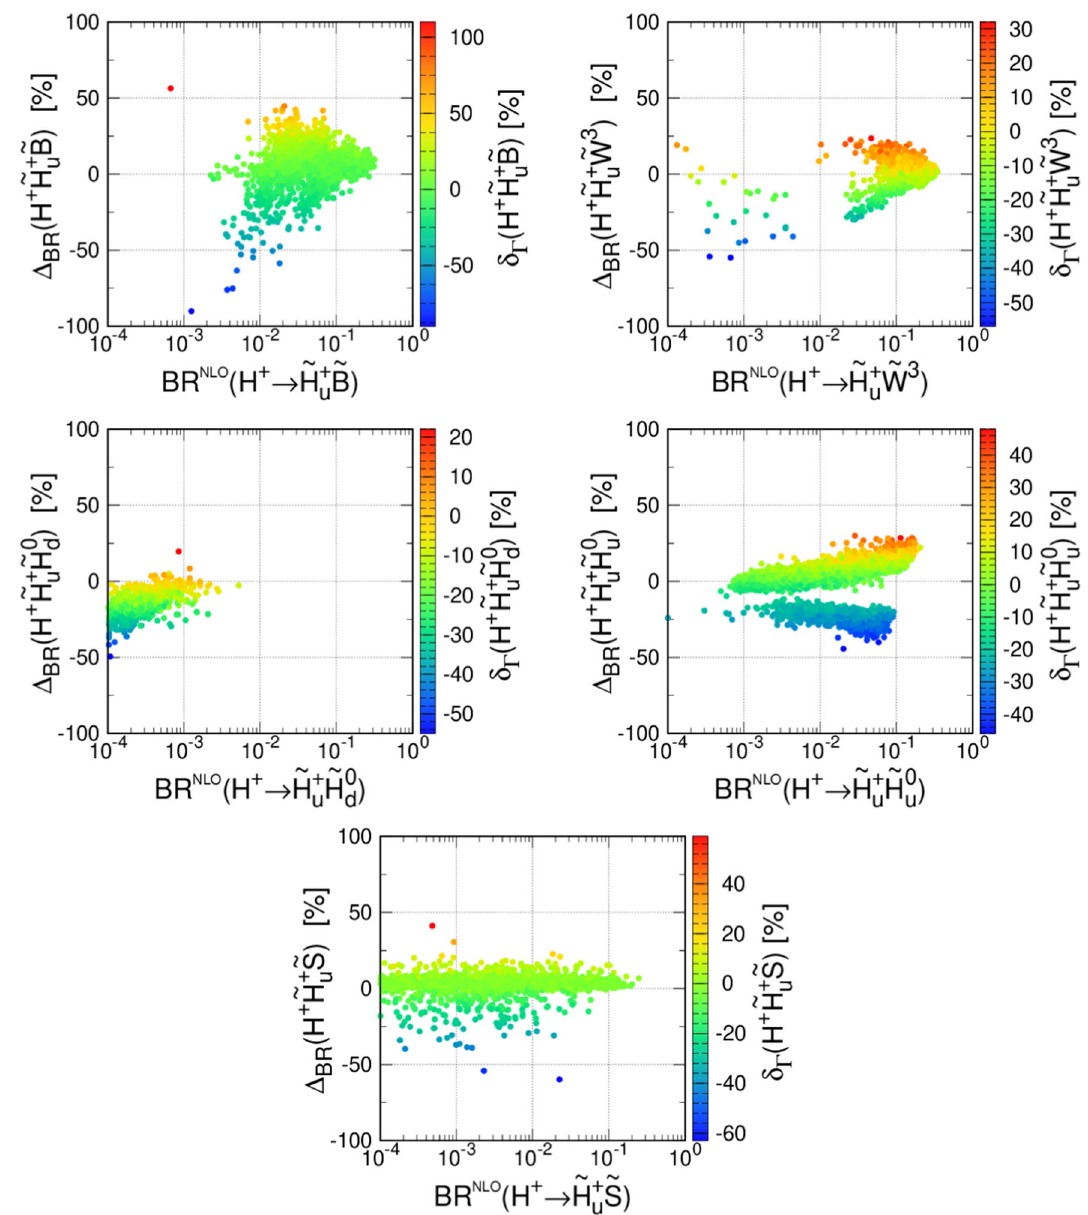
Fig. 5 Same as Fig. 4 but for the charged Higgsino plus neutral electroweakino final